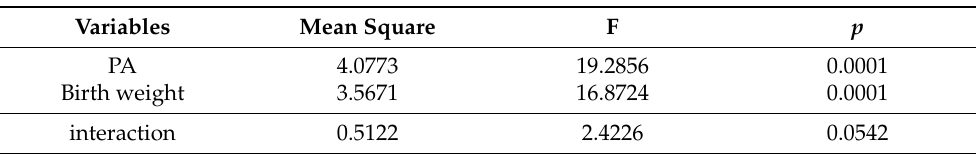
Table 4. The strength of the relationships of the PA and birth weight with sT-score prox (the results of the two-way analysis of variance, PA and birth weight as determining variables, sT-score prox as the dependent